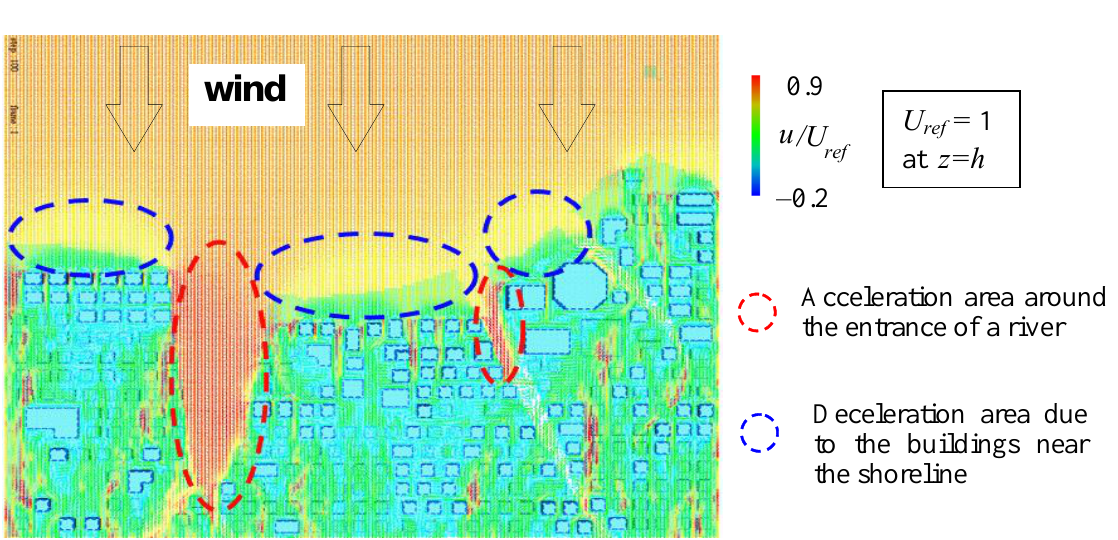
Figure 19. Result of numerical prediction of wind pattern at a height of 15 m for the seashore shown in Figures 17 and 18, using the RIAM-COMPACT.